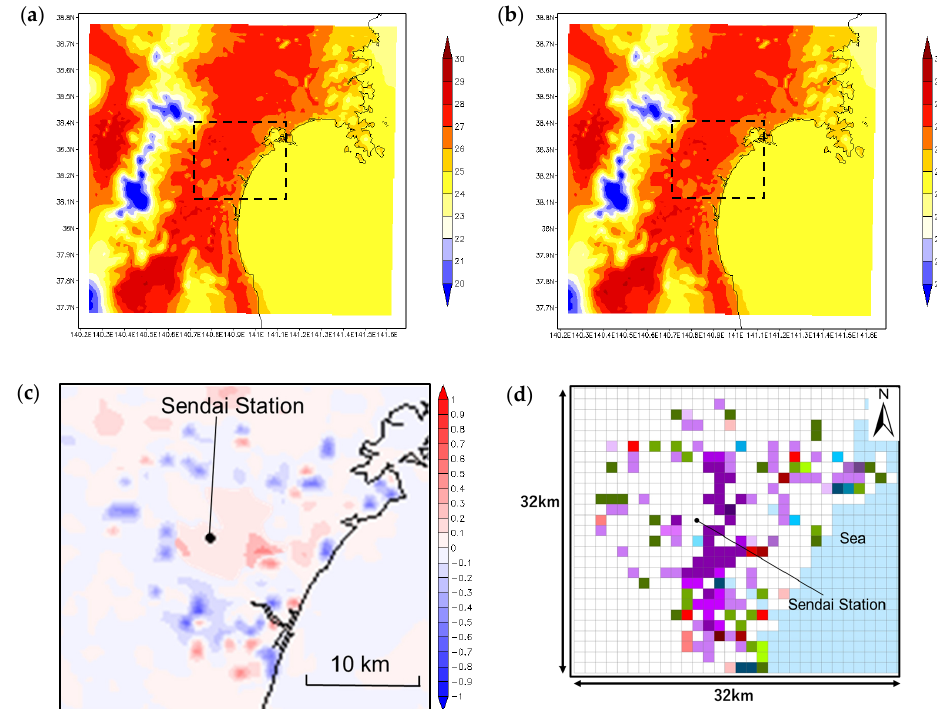
Figure 7. Daytime wind {m/s} fi elds. ( a ) In Case lu_2002; ( b ) in Case lu_2022; ( c ) scalar di ff erence of wind speed (between Case lu_2022 and Case lu_2002); and ( d ) land use changes between 2002 and 2022 in Sendai (reposted Figure 4).